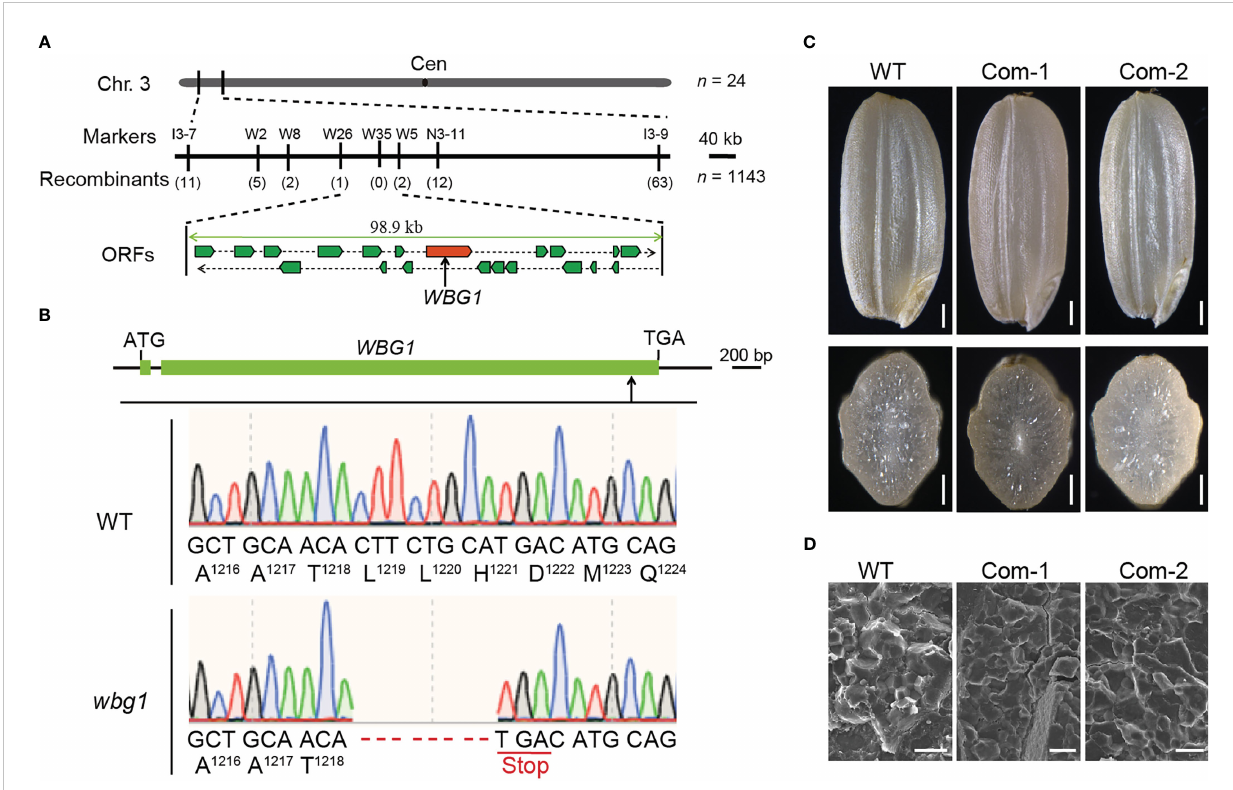
FIGURE 3 WBG1 map-based cloning and complementation tests. (A) Fine mapping of the WBG1 locus. The WBG1 locus was narrowed to a 98.9-kb region on rice chromosome 3 by using fi ne mapping primers listed in Supplementary Table 1. This region includes 20 predicted open reading frames (ORFs). The molecular markers and numbers of recombinants are indicated. Cen, centromere. (B) Exon/intron structure of WBG1 and the mutation site in wbg1 . Green boxes indicate the two exons, and the line between the exons indicates the intron in WBG1 . ATG and TGA indicate the start and stop codons, respectively. An eight-nucleotide deletion in the coding region of WBG1 results in a premature termination codon and protein truncation in wbg1 . (C) Complementation of wbg1 by the introduction of a 6.1-kb fragment containing the 2.3-kb promoter and 3.8-kb full-length coding sequence of FLO10 into the wbg1 mutant. Scale bar, 0.5 mm. (D) Scanning electron microscopy (SEM) images of the belly side of grains from representative complemented lines. Scale bar, 10 m